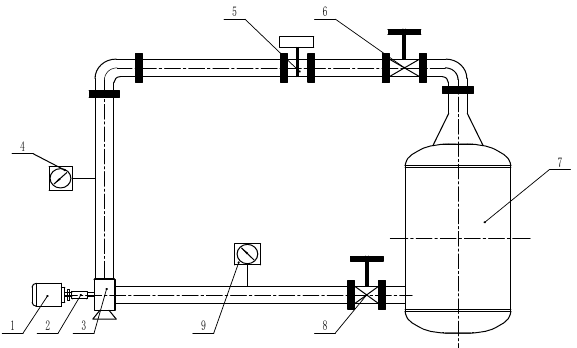
Figure 4. Schematic of test rig: 1. motor; 2. torque meter; 3. centrifugal pump; 4. outlet pipeline pressure gauge; 5. DN100 electromagnetic flowmeter; 6. outlet pipeline valve; 7. water tank; 8. inlet pipeline valve; 9. inlet pipeline pressure gauge.